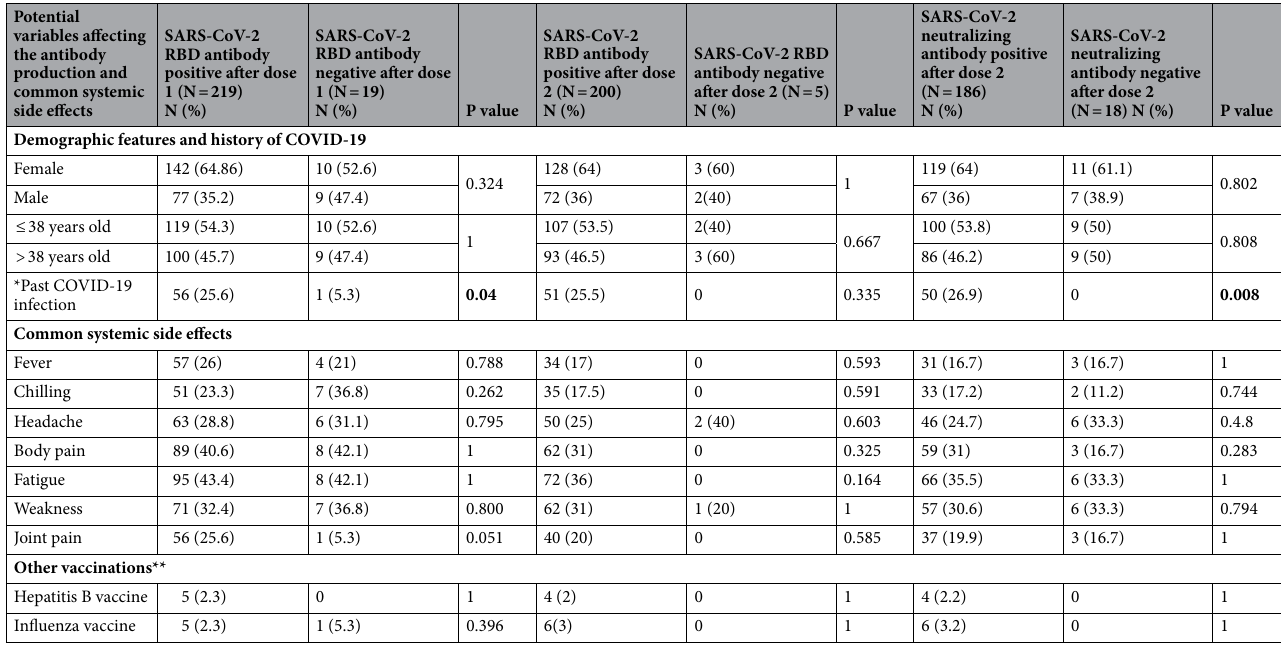
Table 4. Potential variables affecting the antibody production and common systemic side effects based on detection of SARS-CoV-2 RBD and SARS-CoV-2 neutralizing antibody. P value < 0.05 showed by boldface; *previous COVID-19 within a last year; **received vaccine in the last 3 months before COVID-19